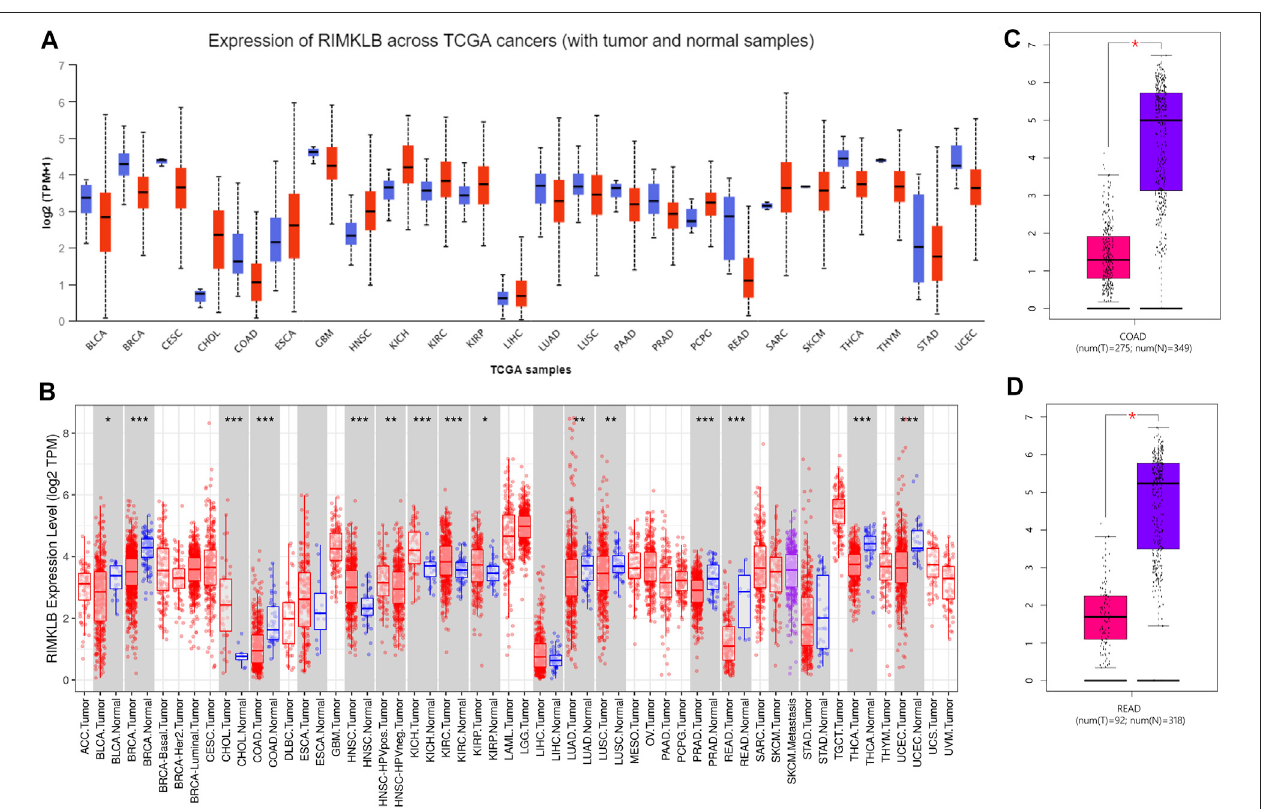
FIGURE 1 | RIMKLB expression levels in different types of human cancers. (A) Increased or decreased RIMKLB in data sets of different cancers compared with normaltissuesintheUALCANdatabase; (B) HumanRIMKLBexpressionlevelsindifferenttumortypesfromTCGAdatabaseweredeterminedbyTIMER(* p < 0.05,** p < 0.01, *** p < 0.001); (C) Decreased RIMKLB in colon cancer compared with normal tissues; (D) Decreased RIMKLB in rectum cancer compared with normal